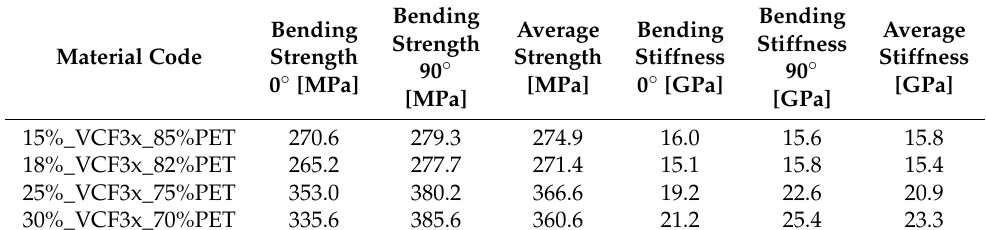
Table 7. The 0 ◦ and 90 ◦ properties of nonwovens by using different carbon fiber volume contents.